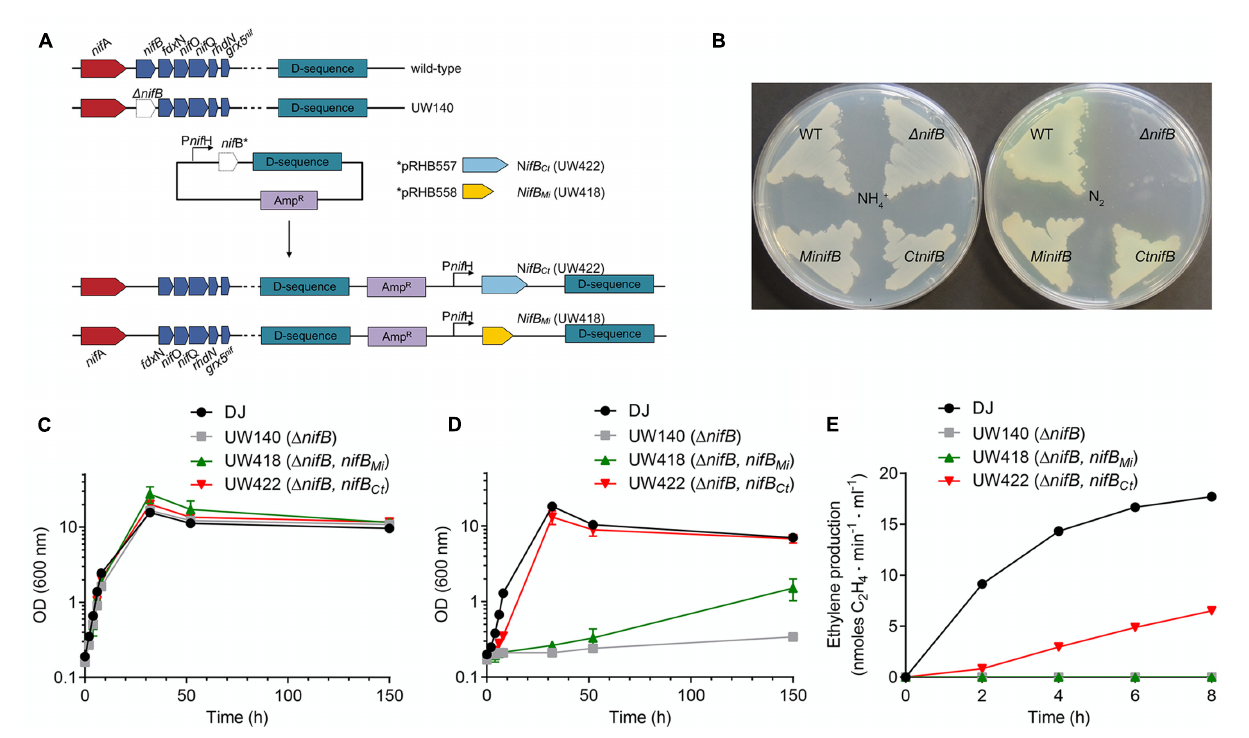
FIGURE 3 | Genetic complementation of A. vinelandii (cid:49) nifB with nifB Ct and nifB Mi genes. (A) Scheme showing the construction of A. vinelandii (cid:49) nifB derivative strains carrying nifB Mi (UW418) and nifB Ct UW422 inserted in their chromosome under the control of a copy of the nifH promoter. (B) Petri dishes with solid Burk media showing growth of A. vinelandii DJ (wild-type strain, WT), UW140 ( (cid:49) nifB ), UW418 ( (cid:49) nifB , P nifH::nifB Mi ) and UW422 ( (cid:49) nifB , P nifH::nifB Ct ) in the presence (left plate) or absence (right plate) of ammonium as nitrogen source. (C,D) Growth curves of DJ, UW140, UW418 and UW422 strains using ammonium (C) or N 2 (D) as source of nitrogen. (E) In vivo acetylene reduction activity of nif derepressed A. vinelandii strains shown as nmol ethylene formed · min − 1 · ml − 1 at a